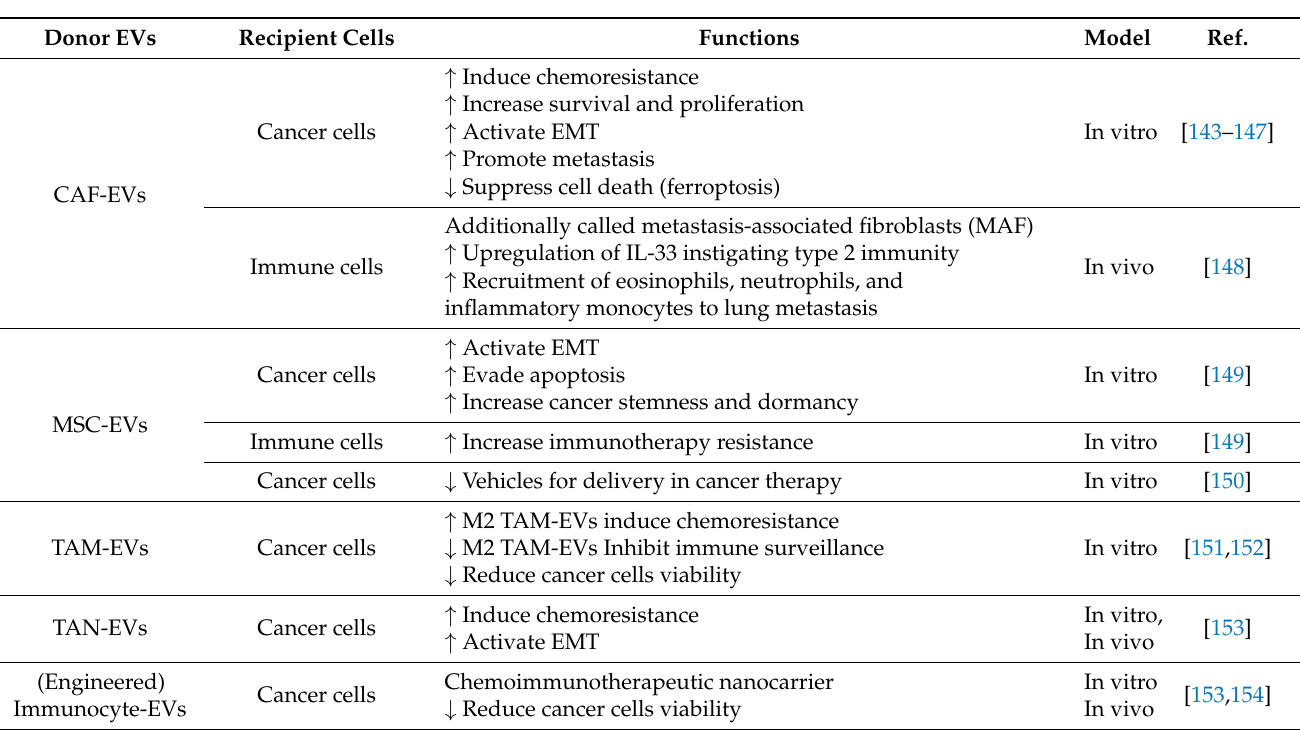
Table 4. Influences of cancer-associated-cells-derived EVs on cancer cells and immune